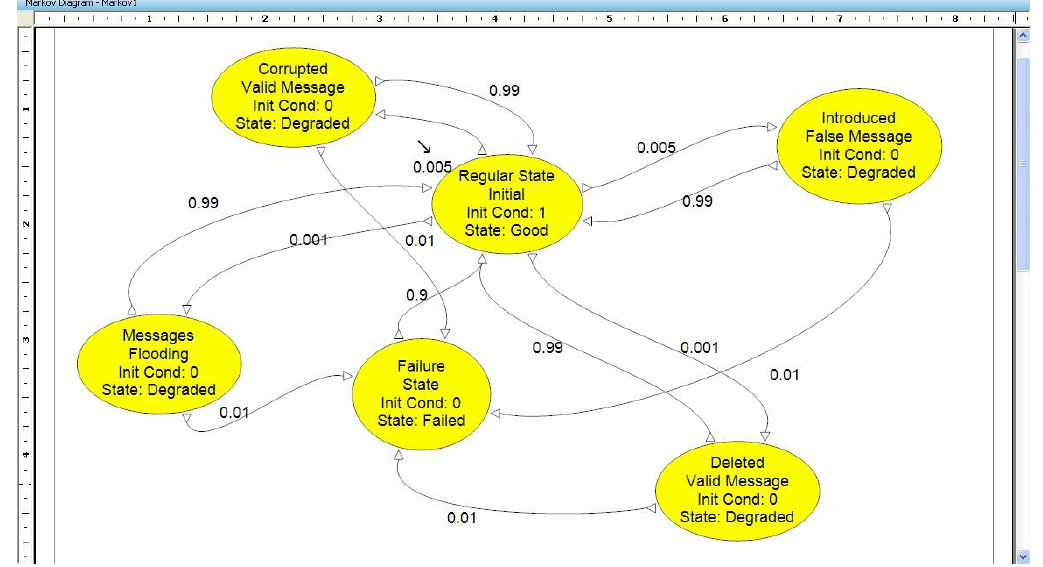
Figure 9. CACC Markov model showing repair from the failure state.